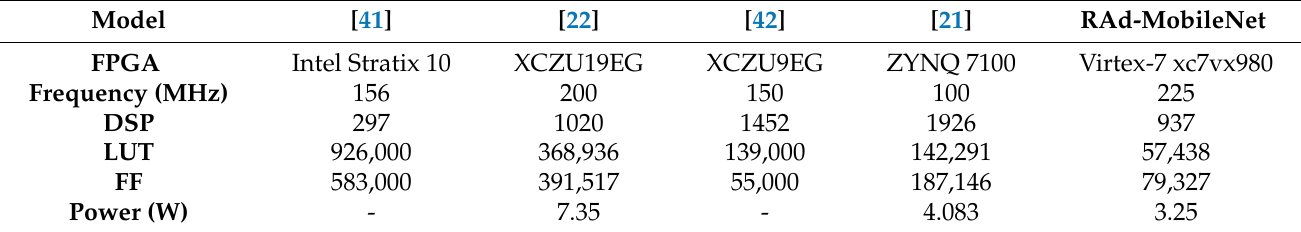
Table 6. Performance comparison with other MobileNet models on